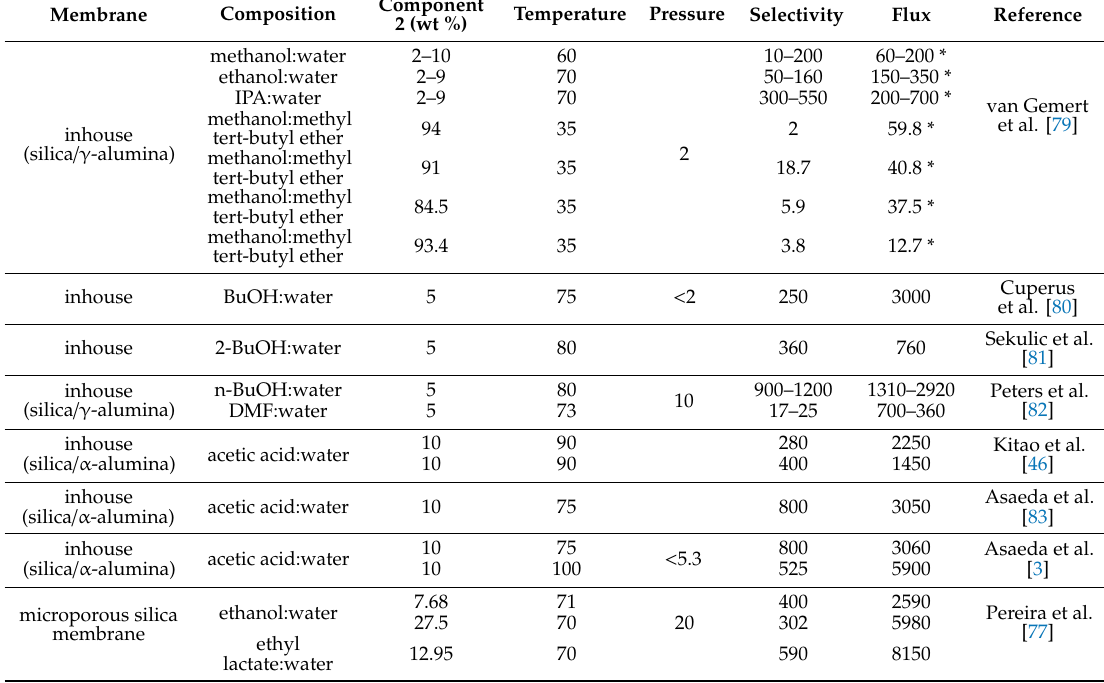
Table 7. In-house manufactured silica membranes and their pervaporation performance for various water–organic as well as organic–organic